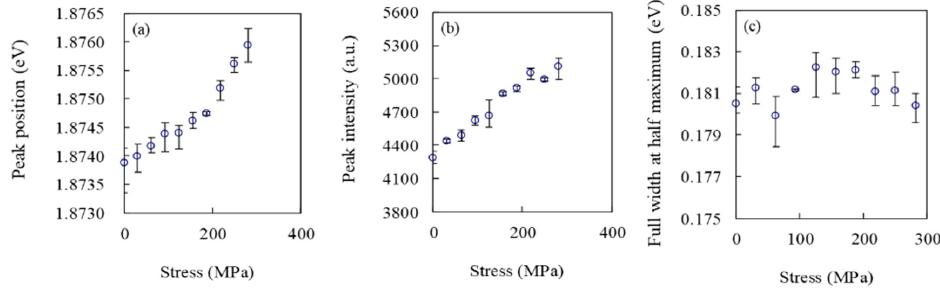
Figure 4. The relationships between applied tensile stress and CL spectral parameters; ( a ) peak position, ( b ) peak intensity, and ( c ) FWHM.